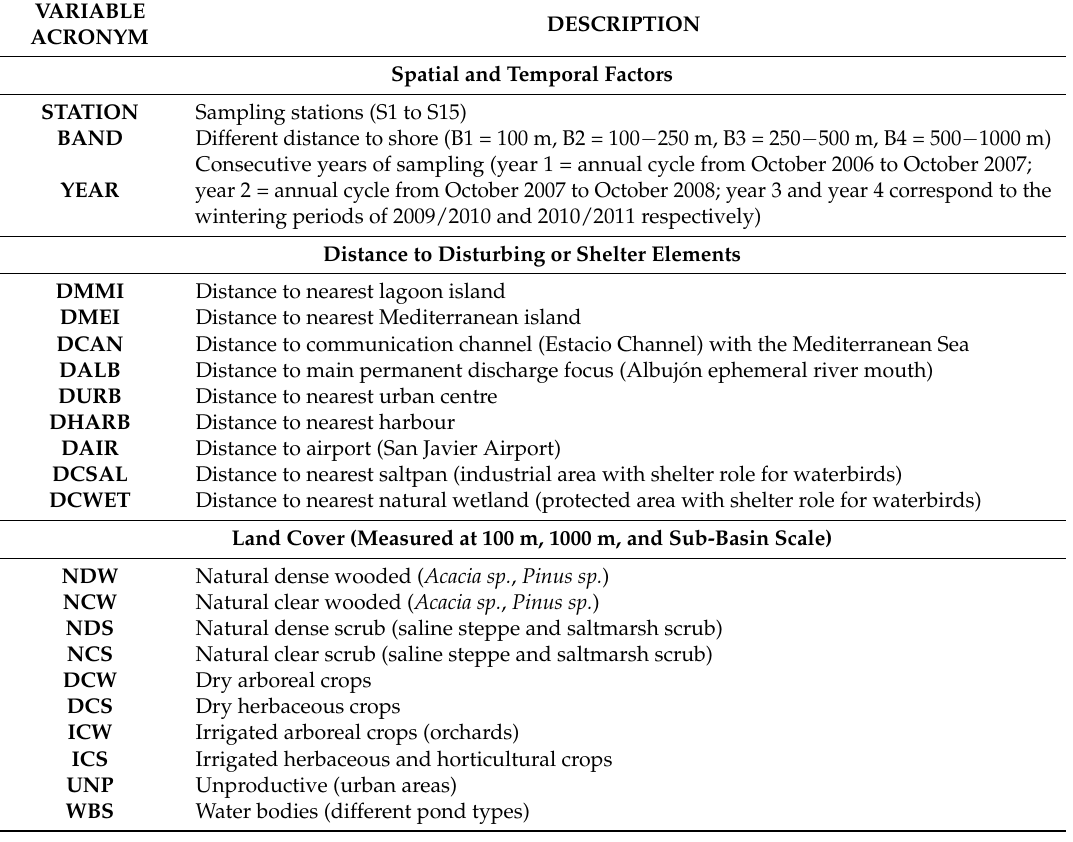
Table 1. Description of the environmental variables used to identify the main pressure factors and land use/cover gradients affecting the